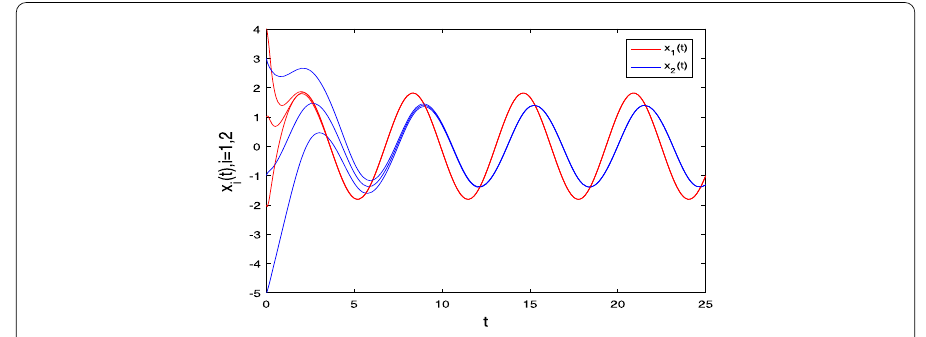
Figure 1 Numerical solutions x ( t ) to system (4.1) with initial values: ( ϕ 1 ( s ), ϕ 2 ( s ), ψ 1 ( s ), ψ 2 ( s )) ≡ (2sin t + 1, –2cos t – 3,2,0),(2cos t + 2,3sin t – 1,0,3),(–3sin t – 2,–4sin t +